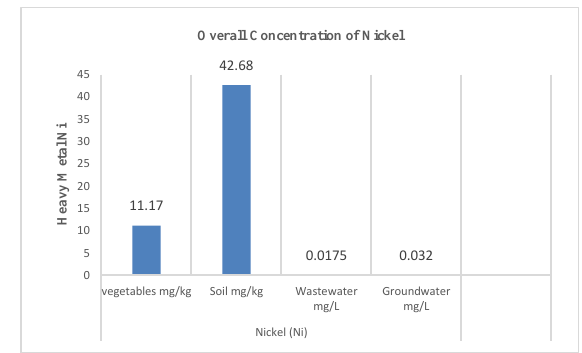
Figure 6: Overall Concentration of